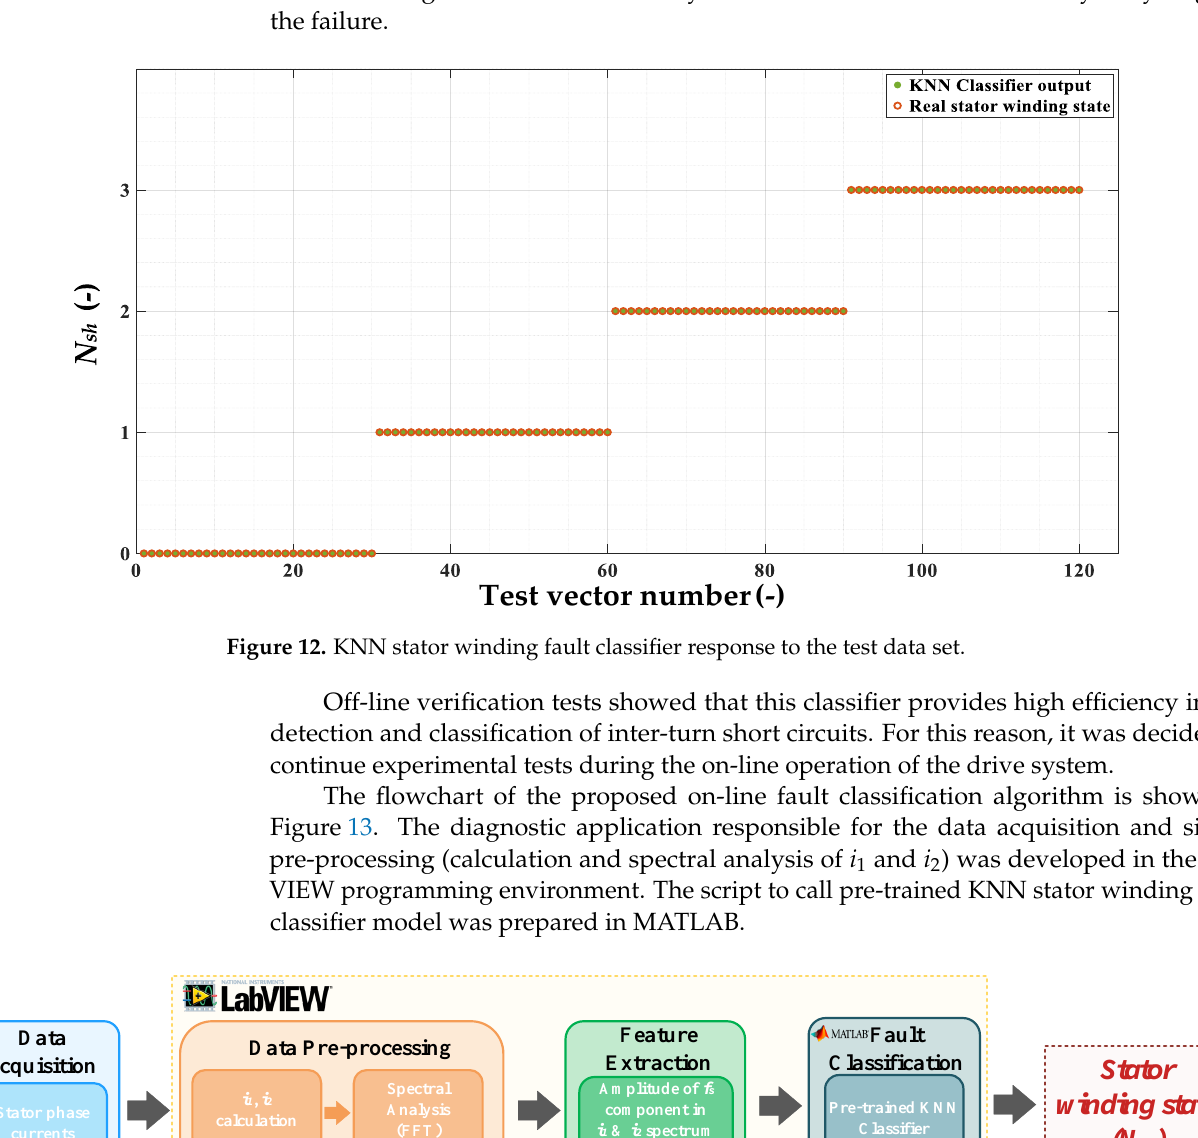
Figure 14. KNN-based stator winding fault classifier responses during the on-line operation—Test 1 ( f s = 100 Hz, T L = var). In the next scenario (Test 2), the operation of the proposed KNN classifier was veri- fied during the momentary (for 1 ÷ 2 s) short circuiting of one, two and three shorted turns, respectively. This test was also carried out for different load torques T L = (0 ÷ 1) T N and f s = f sN = 100 Hz. In this case, the C EFF was equal to 98.6%, which confirmed the satisfying prop- erties of this solution (Figure 15). Finally, the last test (Test 3) was carried out to verify the classifier operation for power supply frequency (rotational speeds) different from the rated value ( f sN ). Before the test, the training data set was extended with vectors corresponding to the motor operation at frequencies lower than the rated one— f s = {90 Hz; 80 Hz; 70 Hz; 60 Hz}. With this set, the classifier was re-trained without changing its parameters, and an on-line verification test was performed. The classifier responses and the actual states of the stator winding for